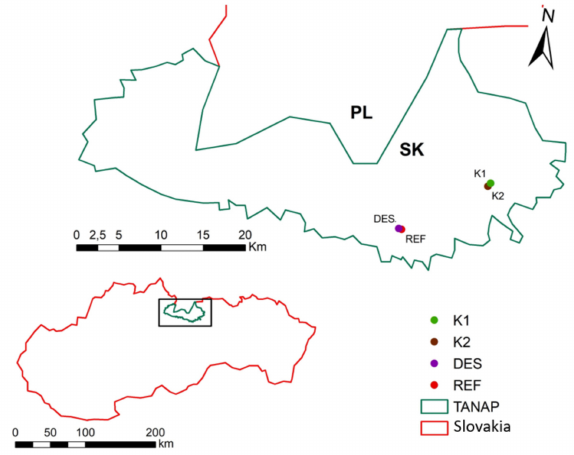
Figure 1. Map of research area; Tatra Mountains National Park, Slovakia (TANAP). Four types of forest: K1 = attacked by bark beetle; K2 = destroyed by bark beetle; DES = with removed trees; REF =